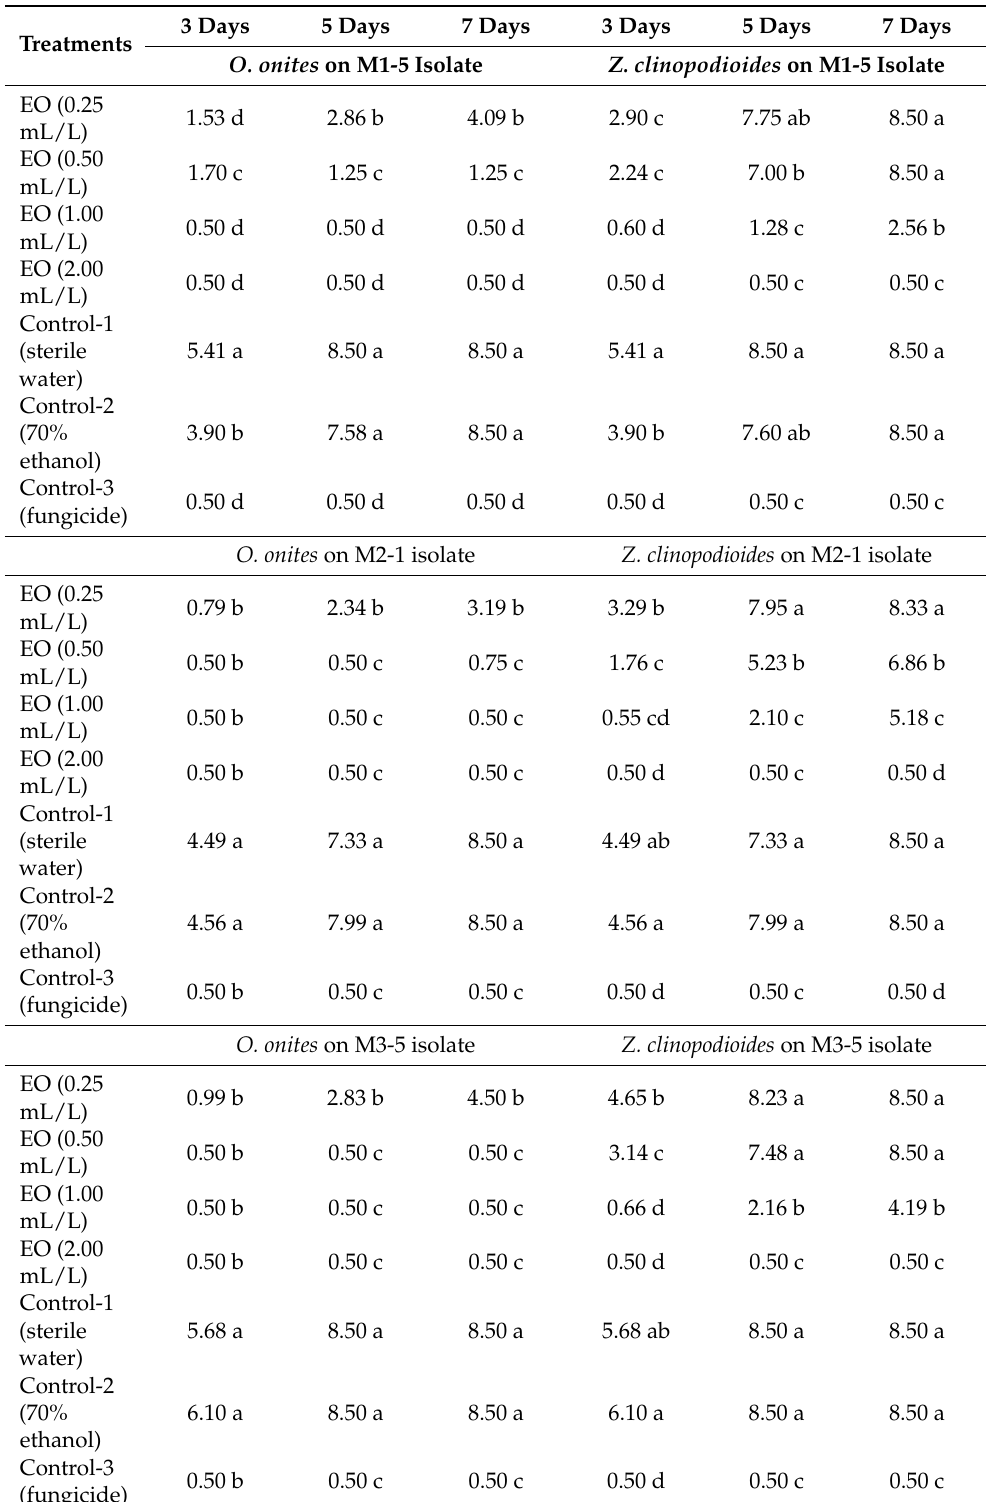
Table 1. Effect of different application doses of O. onites and Z. clinopodioides essential oils, added to the PDA media, on the mycelial growth (colony diameter—cm) of B. cinerea isolates (M1-5, M2-1 and M3-5) during seven days of